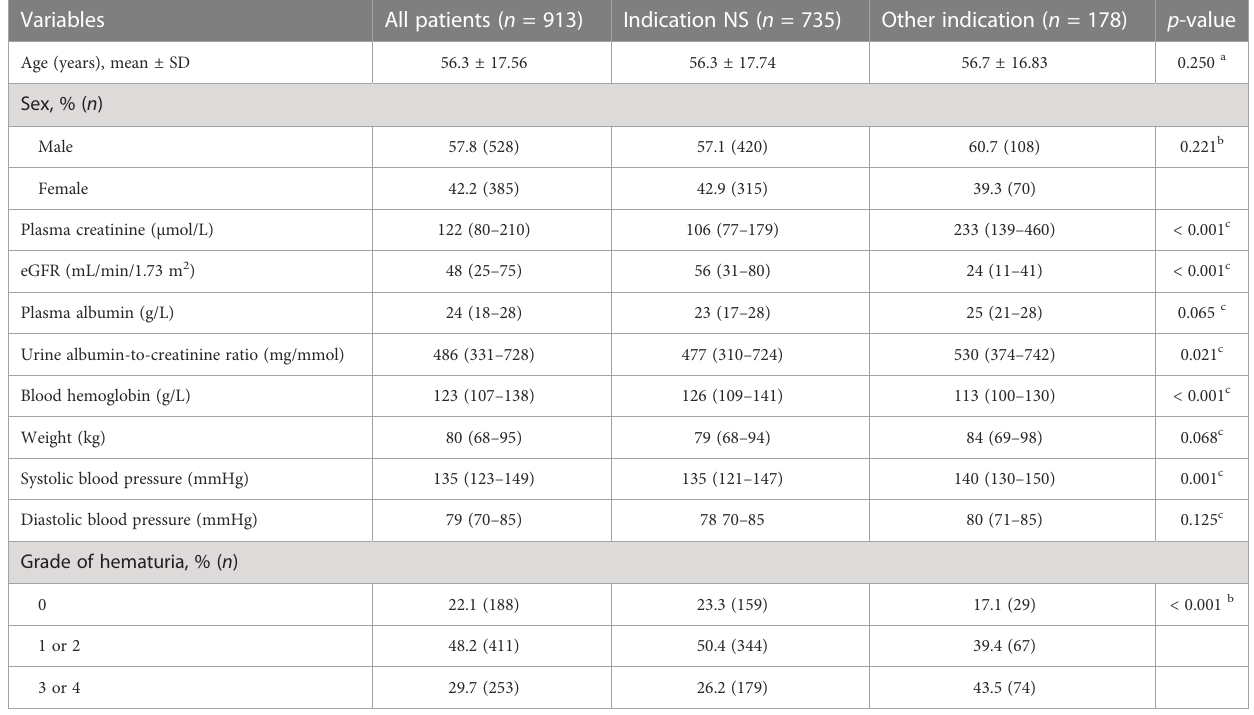
TABLE 2 Demographic data and clinical characteristics at the time of biopsy.